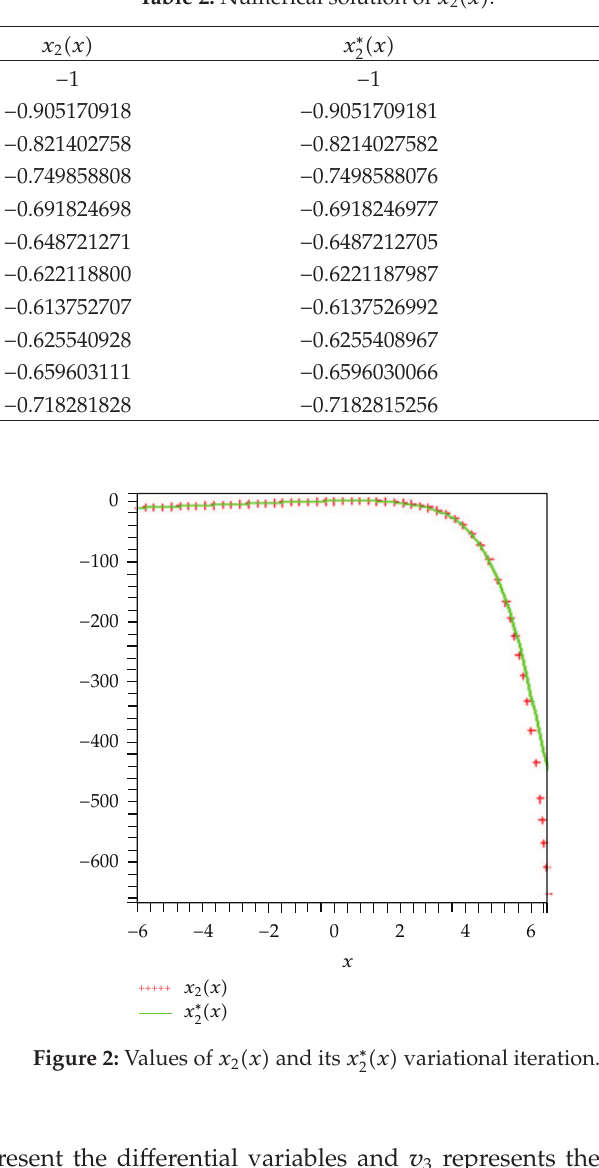
Di ff erential-algebraic equation (cid:3) DAE (cid:4) is a Hessenberg index-3